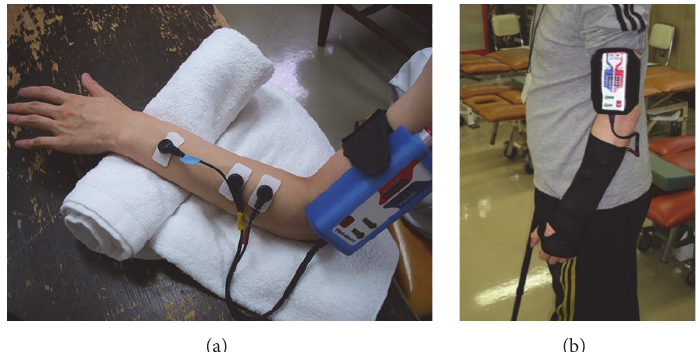
Figure 1: (a) Closed-loop electromyography- (EMG-) controlled neuromuscular electrical stimulation (NMES). A pair of electrodes for EMG detection and stimulation are placed on the affected extensor digitorum communis muscle, and one electrode for stimulation is placed on the affected extensor indicis muscle. (b) Participants wear a wrist-hand splint and carry a closed-loop EMG-controlled NMES with arm holder for 8 hours during the